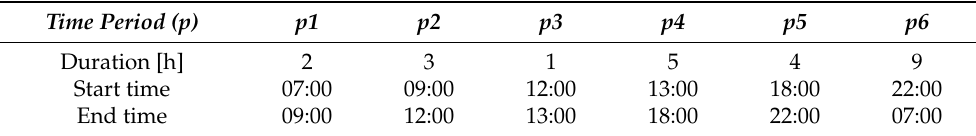
Table 1. Time periods used in the model.